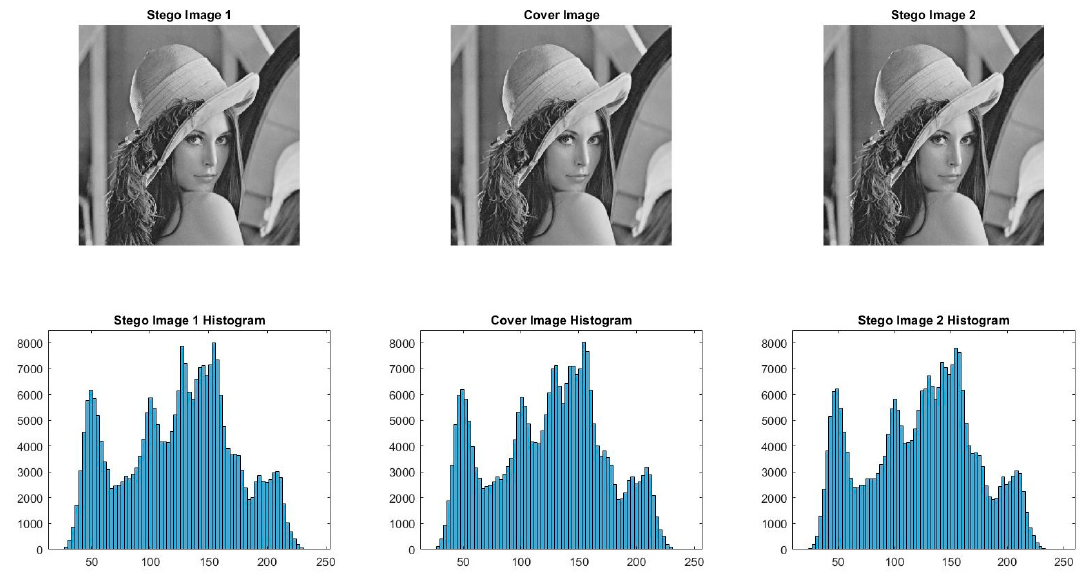
Figure 9. Comparisons of histogram analysis for n = 2 in grayscale Lena image.